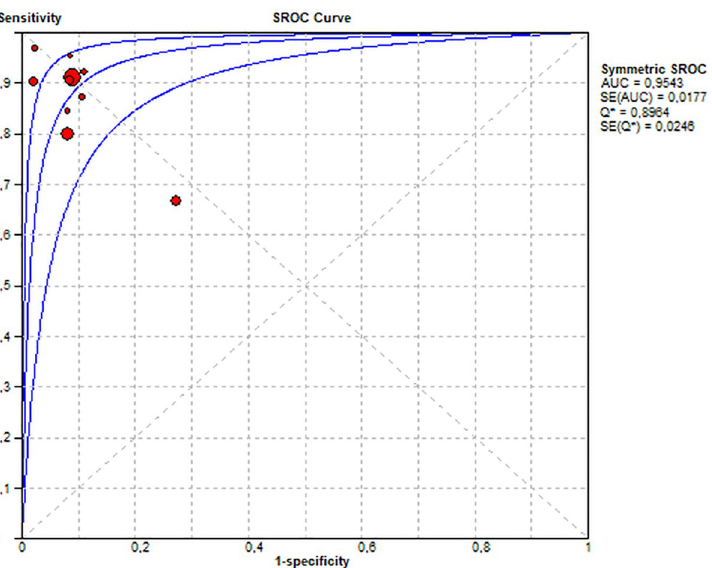
Fig 3. Summary receiver operating characteristic (SROC)